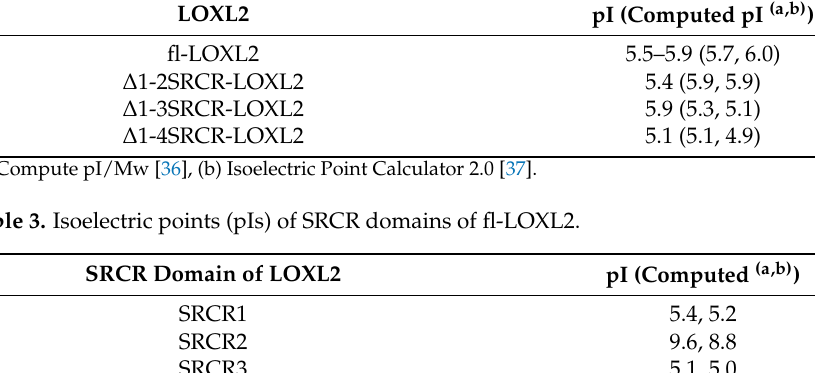
Table 2. Isoelectric points (pIs) of the series of recombinant LOXL2s in this study. LOXL2